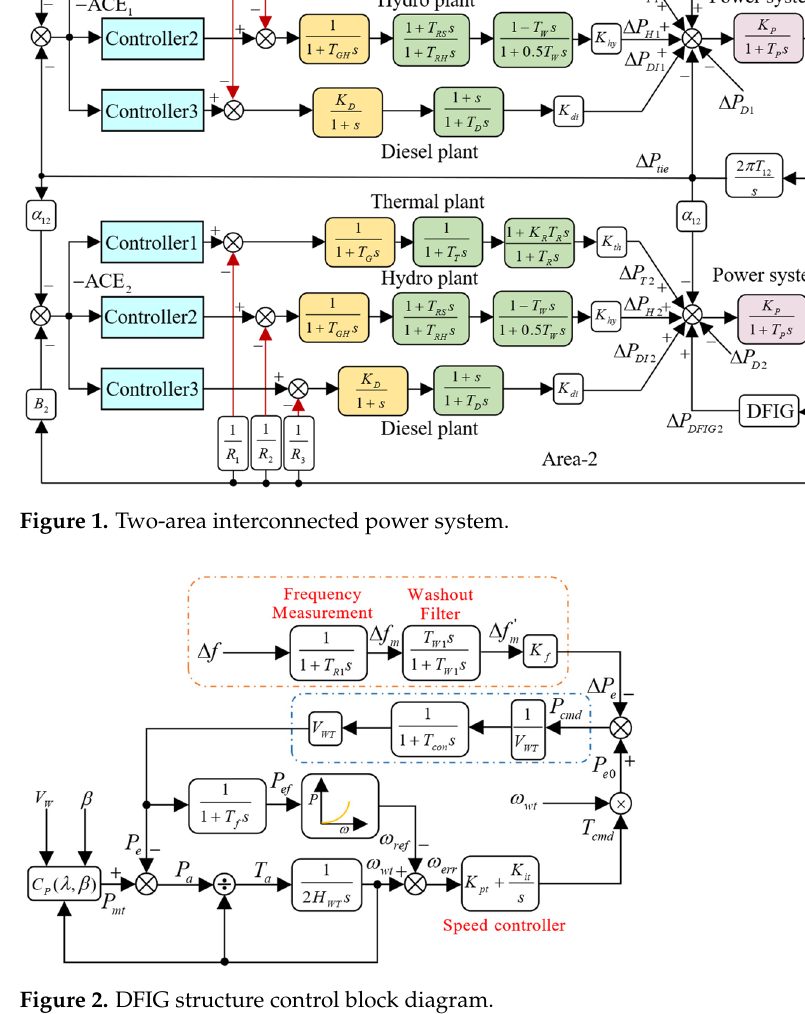
Figure 2. DFIG structure control block diagram.